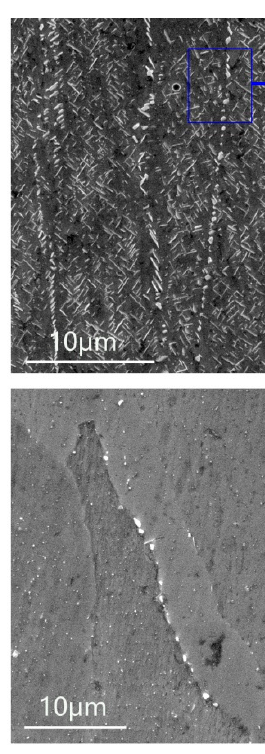
Figure 2. Precipitates distributions of as-deposited sample and solution-treated samples at different temperatures: ( a ) As-deposited, ( b ) 930 °C, ( c ) 980 °C, ( d ) 1030 °C, ( e ) 1080 °C, ( f ) 1130 °C, ( g ) 1180 °C, ( h ) 1230 °C. 3.2. Grain Features Though the solution heat treatment can homogenize the element distribution of the sample, the static recrystallization phenomenon triggered by the solution heat treatment also can affect the